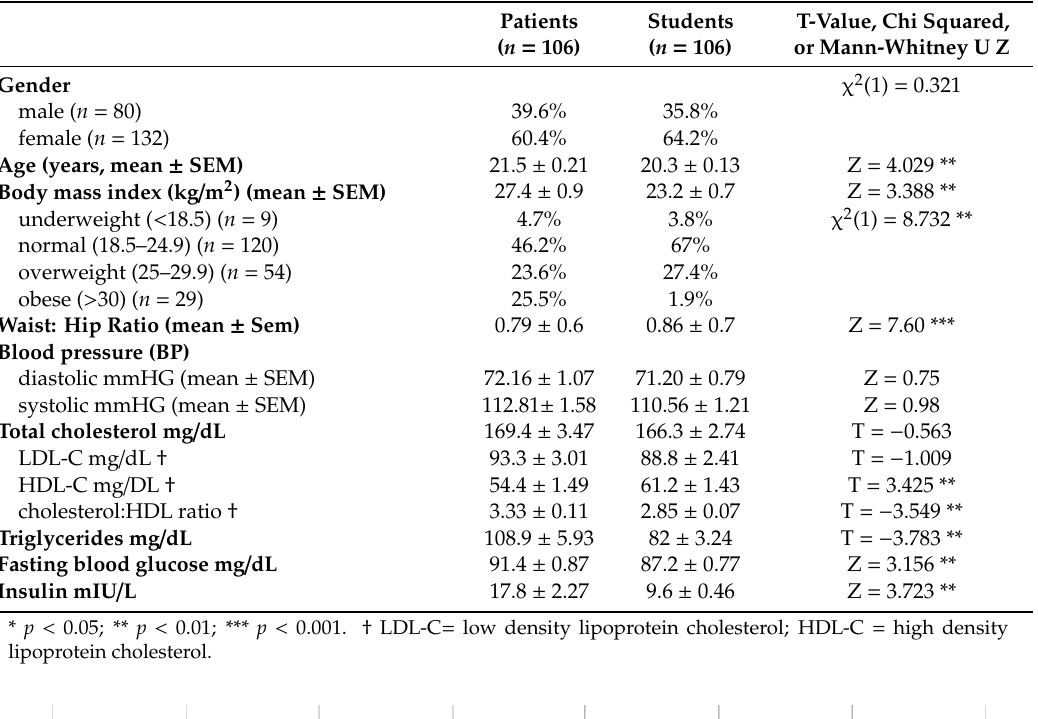
Table 2. Demographic and cardiometabolic risk factors in young adults who were patients with diagnosed depression or students at a university.